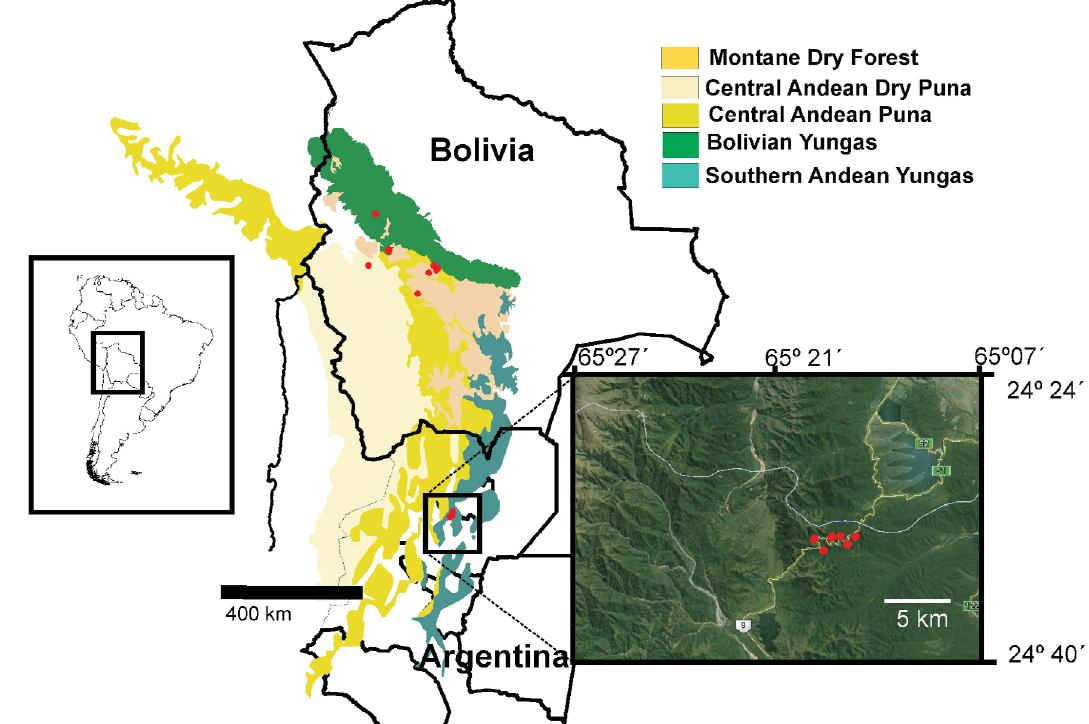
Figure 2 . Map showing the known distribution of Epiphragmophora estella in Bolivia and new records in Salta,